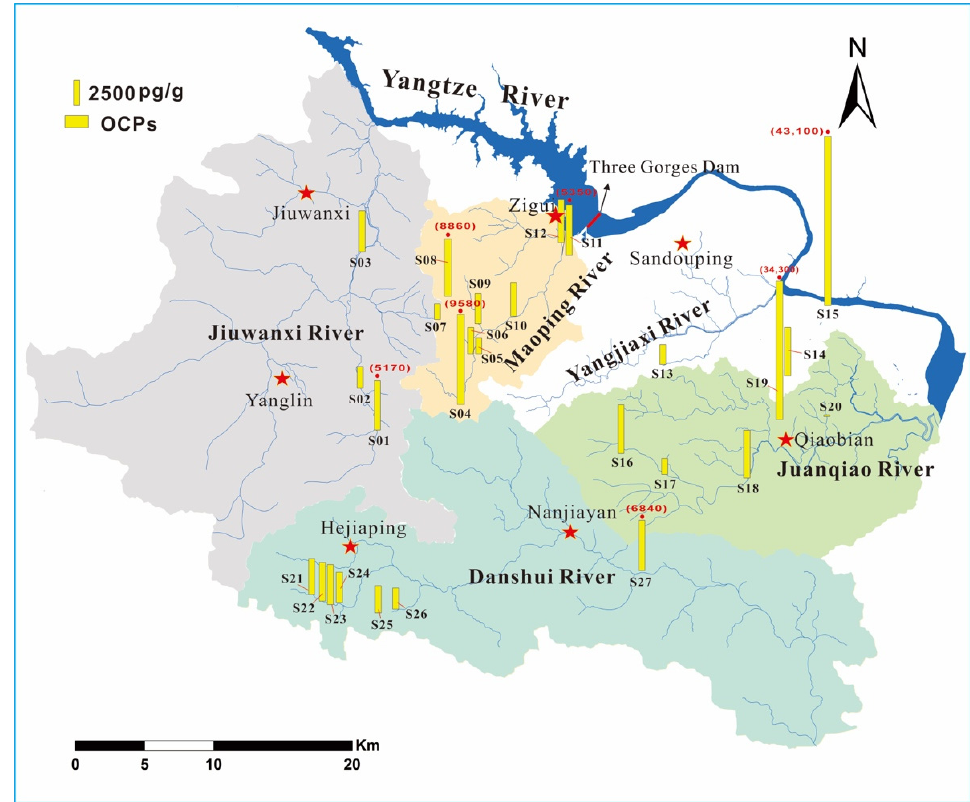
Figure 3. The spatial distribution of soil OCPs in different river basins.